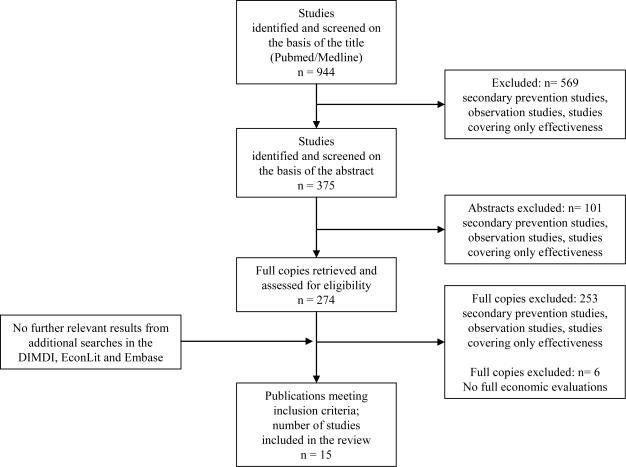
Flow of information through the different phases of the systematic review according to PRISMA guidelines [23].